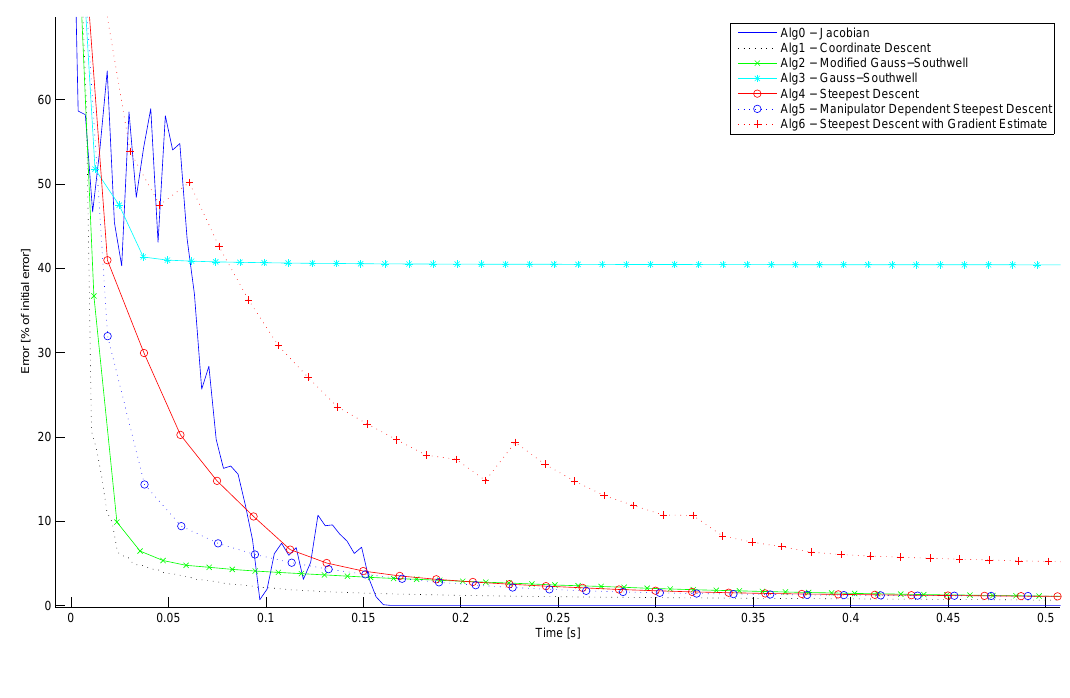
Figure 5: Convergence of algorithms with initial conditions far from a solution with respect to